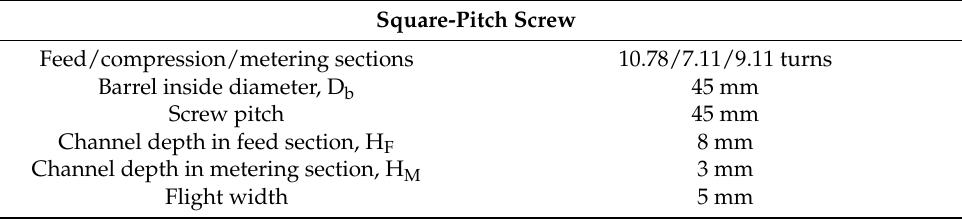
Table 1. Extruder screw geometry and dimensions.